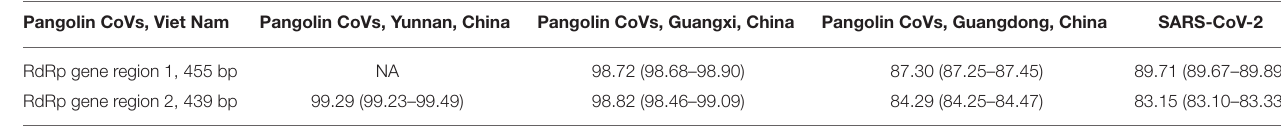
TABLE 5 | Mean sequence identity and its range between Pangolin CoV sequences identified in Viet Nam and Pangolin CoV sequences identified in China (Yunnan, Guangxi, and Guangdong provinces) and SARS-CoV-2 in two conserved regions of the RdRp gene. Pangolin CoVs, Viet